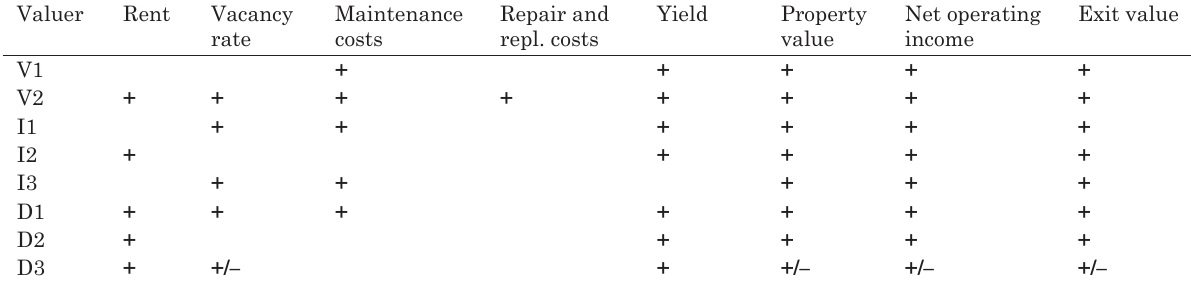
Table 4. Summary of the